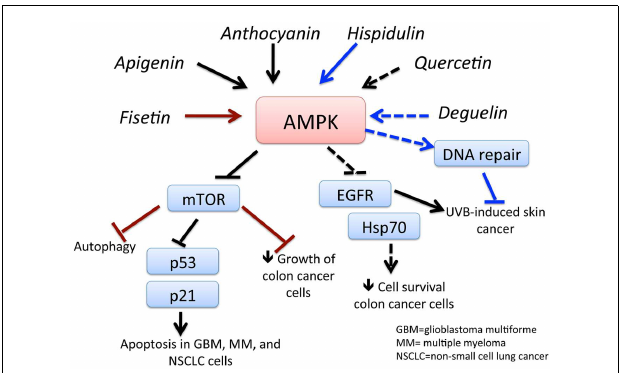
FIGURE 4 | Schematic representation ofAMPK-dependent anti-cancer effects of flavonoids and related compounds .This figure shows the major flavonoids and their AMPK-dependent effects on inhibition of cancer growth. Apigenin and anthocyanin activates AMPK, which inhibits mTOR signaling, leading to apoptosis of GBM, multiple myeloma (MM), and non-small cell lung cancer (NSCLC) cells. Activation of AMPK by fisetin and hispidulin also inhibits mTOR, resulting in autophagy-dependent cancer cell death and decreased growth of colon cancer cells, respectively. Quercetin inhibits survival of colon cancer cells by downregulation of epidermal growth factor receptor (EGFR) signaling and heat shock protein (hsp)70 expression. Activation of AMPK deguelin leads to UVB-induced tumorigenesis in a non-melanoma skin cancer mouse model. See text for effects of other flavonoids and related